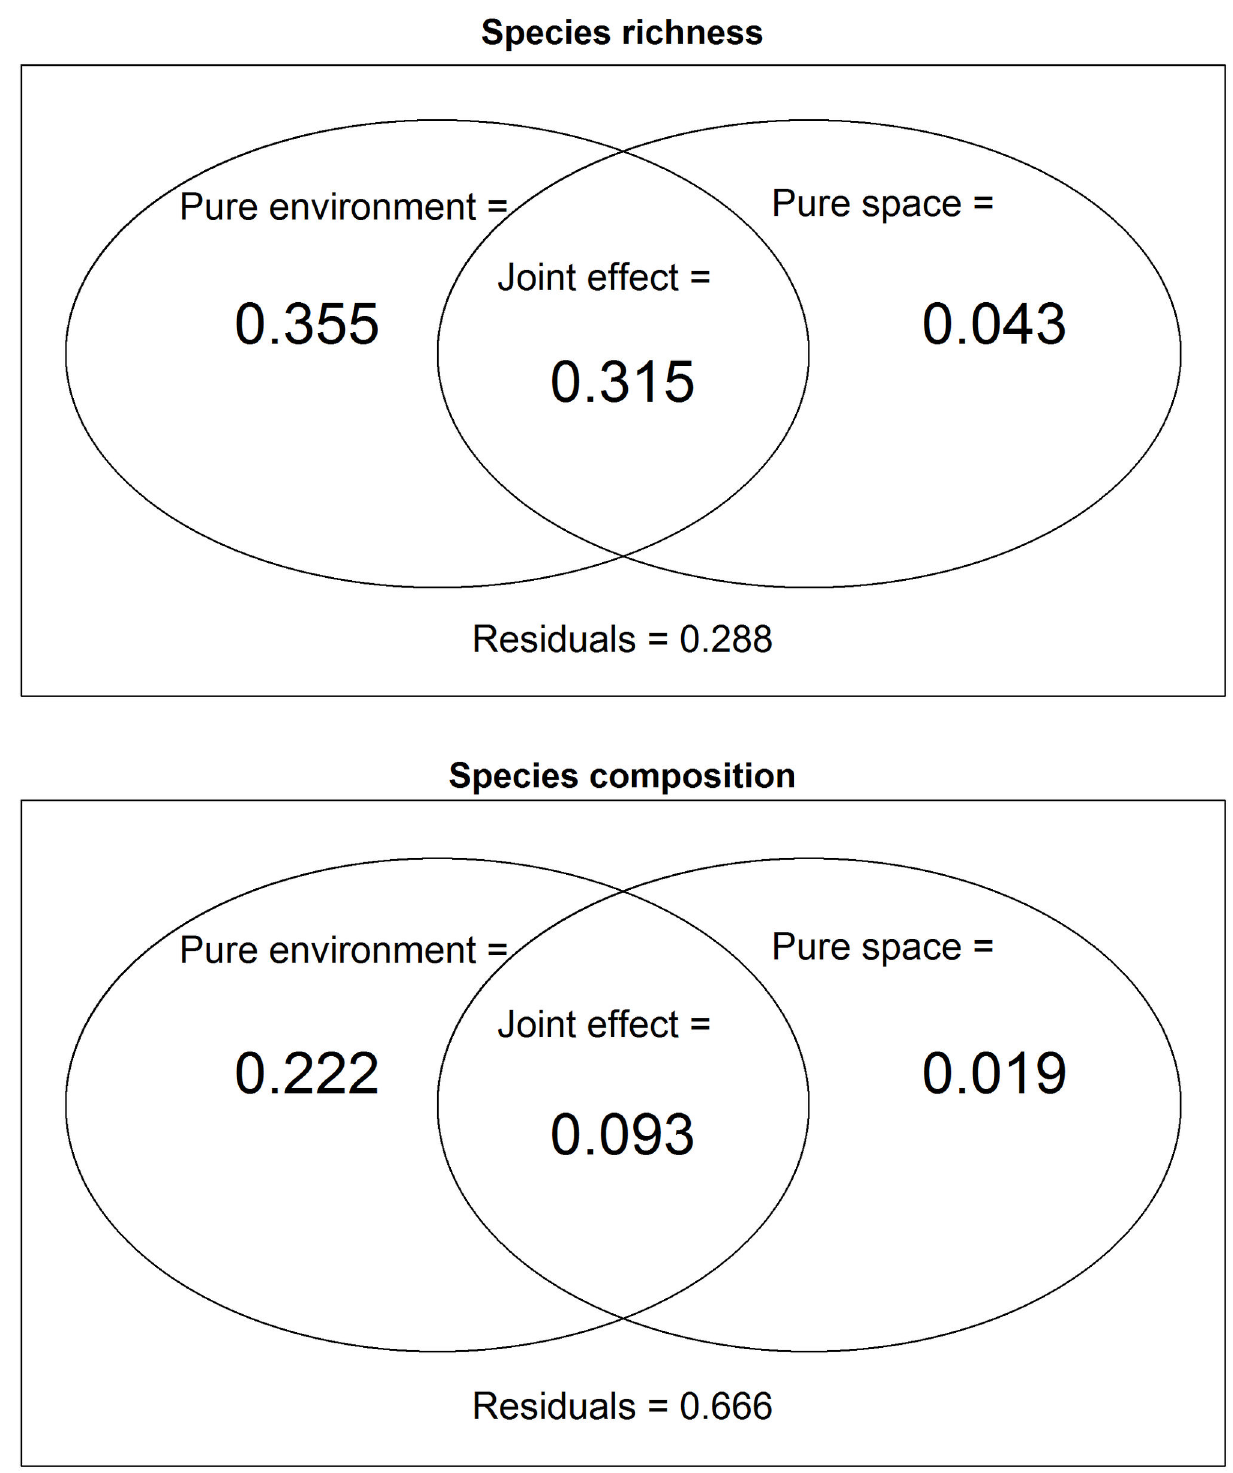
Figure 3. Variation partitioning results of all species. The two figure panels show Venn diagrams that represent the partitioning of the variations of the species richness and composition constrained by the selected environmental variables (environment) and PCNMs (space). Each box represents 100% of the variation in the corresponding response variable. The fractions shown are the adjusted R-square statistics. doi: 10.1371/journal.pone.0081308.g003 PLOS ONE |